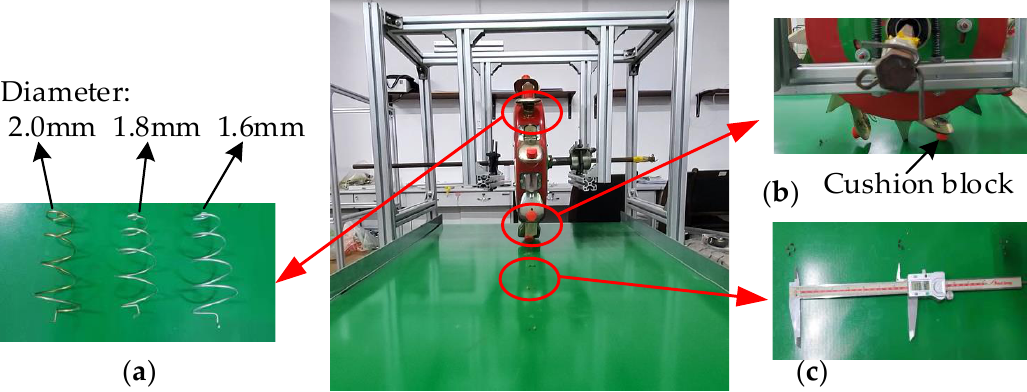
Figure 10. Bench test. ( a ) Three springs with different diameters; ( b ) Cushion block; ( c ) Measurement of hole